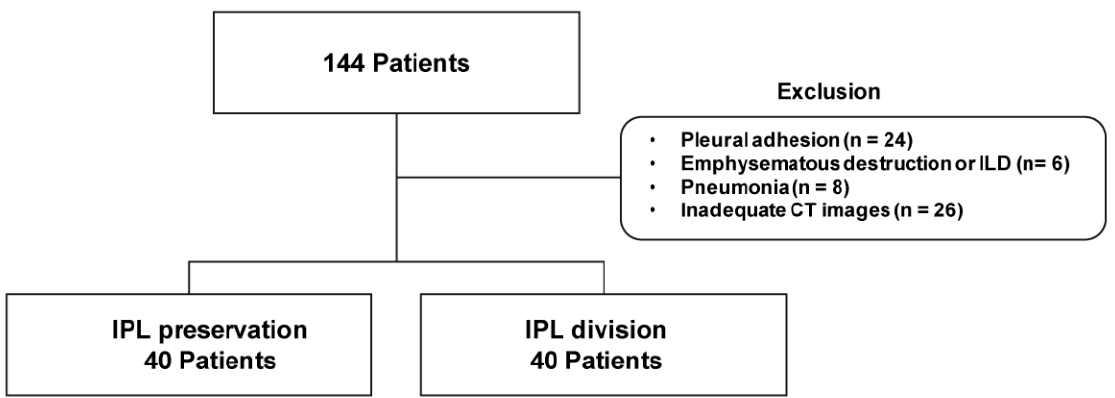
Figure 1. Flowchart of patient selection.